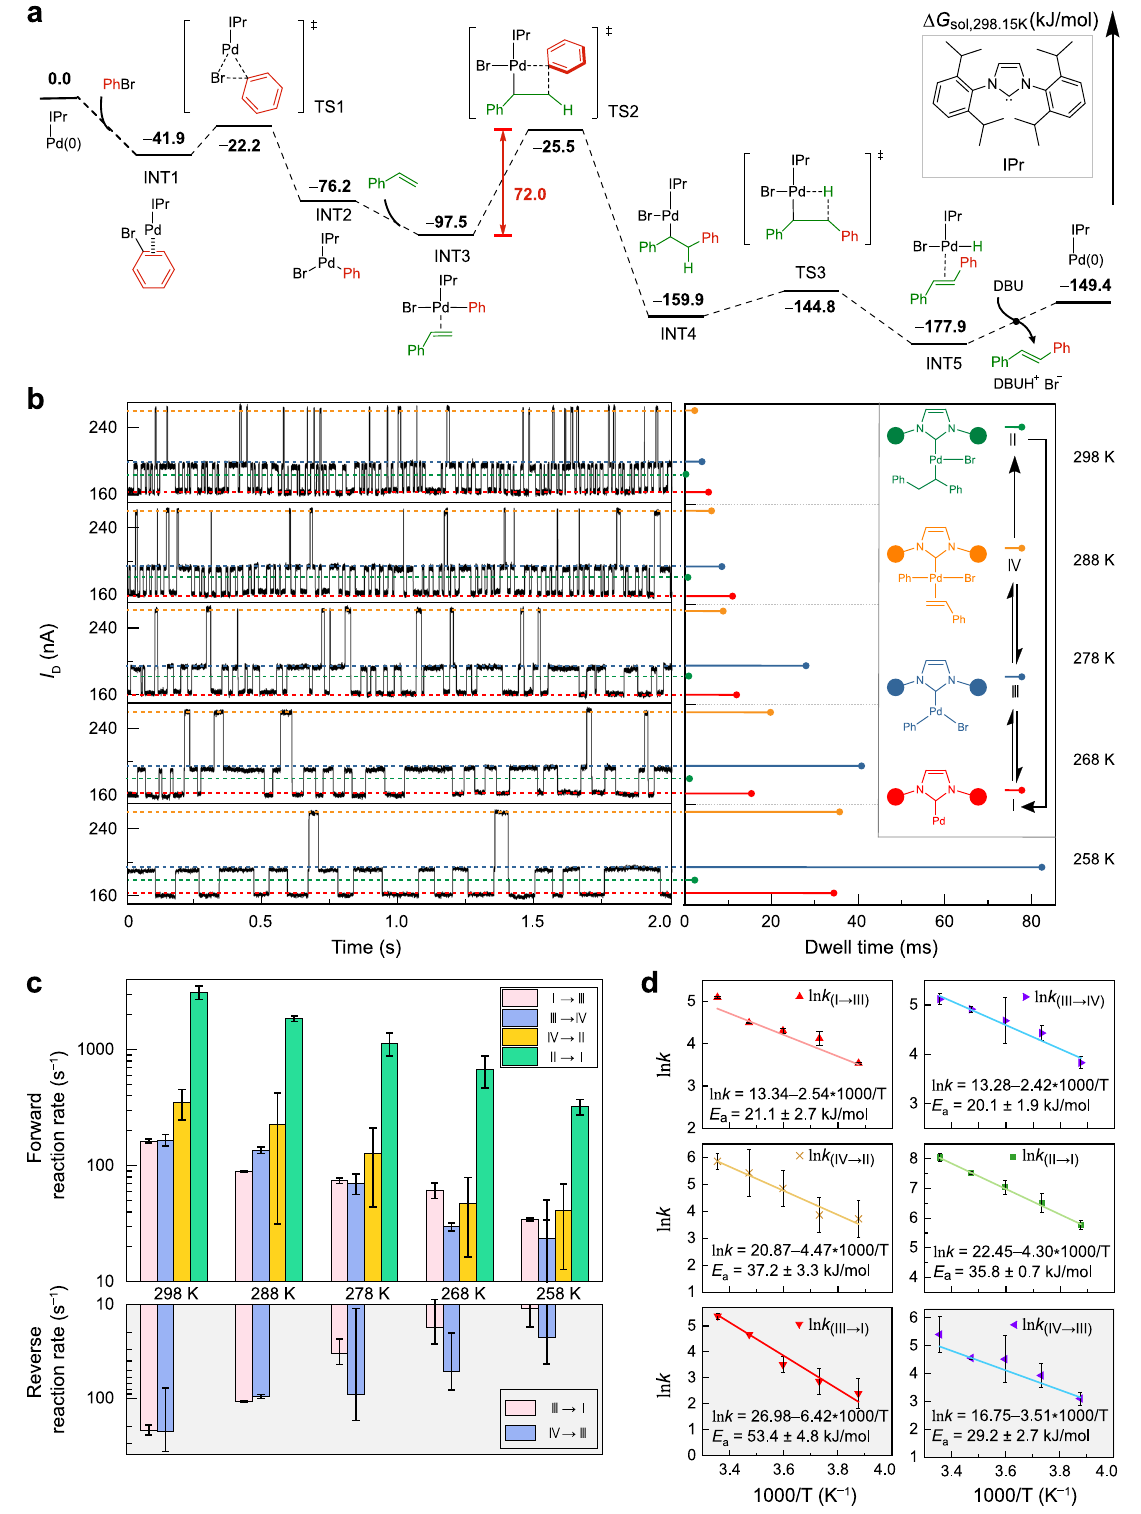
Fig.3|Theoreticalfreeenergysurfacecalculationandexperimentalkineticsof the single-molecule Mizoroki – Heck reaction. a Theoretical free energy surface calculation. IPr 1,3-bis(2,6-diisopropylphenyl) − 1 H -imidazol-3-ium-2-ide, TS transi- tion state, INT intermediate. b The single-molecule Mizoroki – Heck reaction under different temperatures (left) and the corresponding attribution to the assignment of the four current levels (right). Inset: detected transformations of the current levels.Reactionconditions:1mMPhBr,1mMstyreneand1mMDBUinDMF. c Rate constants for each elementary reaction at various temperatures. The error scales